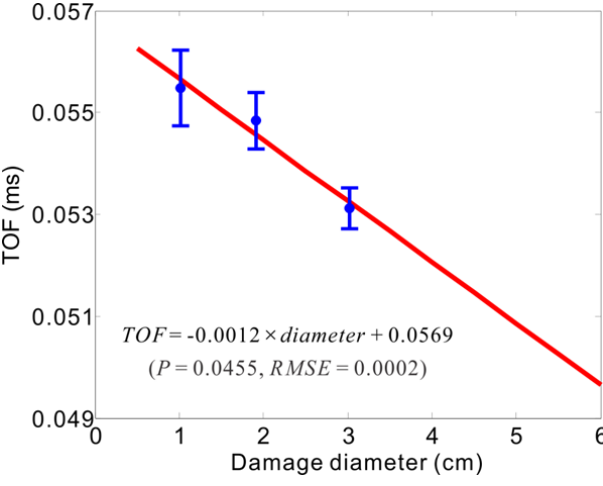
Figure 12. Prediction trend on progressive damage.